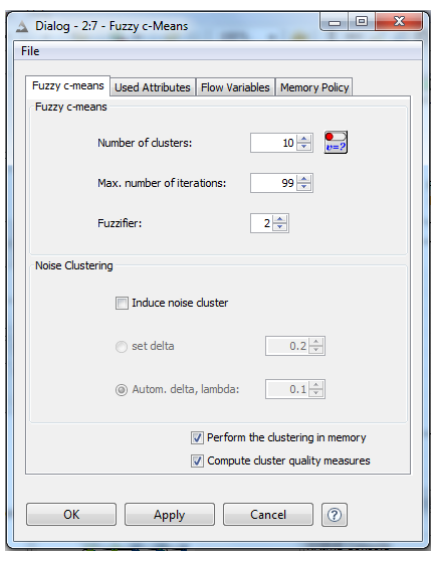
Fig. 9. The dialog of the fuzzy c-means clustering node, displaying the available options.